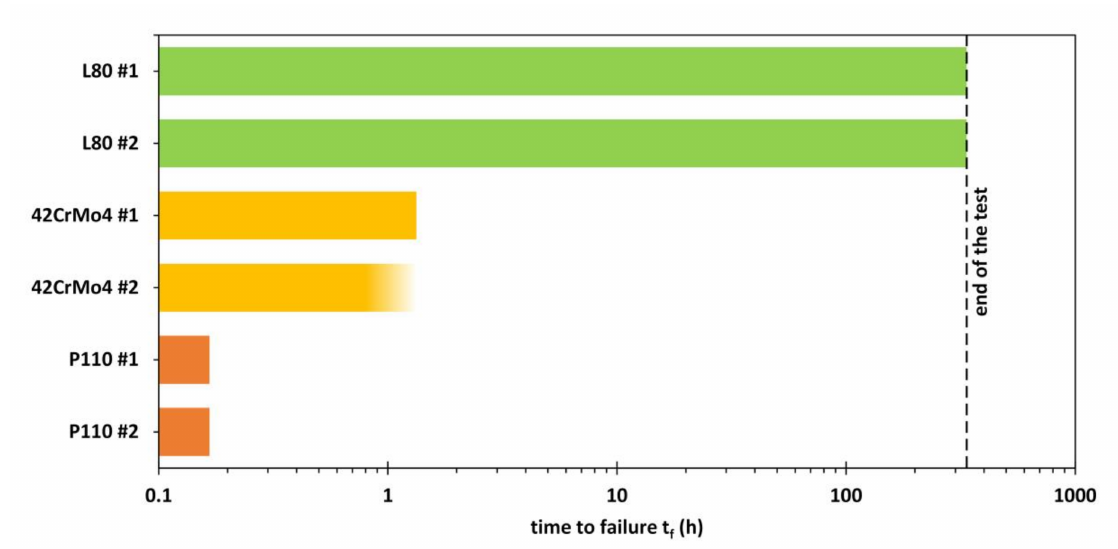
Figure 9. Results of the CLTs at 90% of the SMYS in acidified H 2 S-saturated aqueous brine with 5.0 wt.% NaCl and 0.5 wt.% CH 3 COOH at room temperature (NACE Solution A). The bar with a blurred end represents a failure where time is not exactly